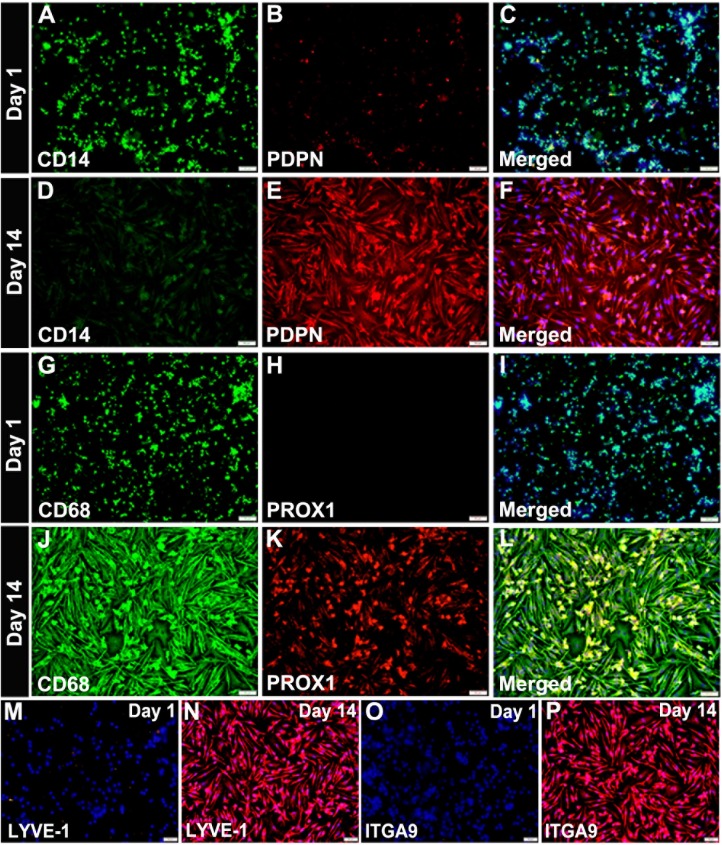
TLR4-reprogrammed monocytes upregulate LEC-specific proteins and downregulate some myeloid markers.CD14+ monocytes seeded on slides were double-stained on Day 1 in culture or on Day 14 (10 days with CSF1 followed by 4 days LPS) for expression of myeloid markers (A, D) CD14, and (G, J) CD68, and lymphatic-specific proteins (B, E) PDPN, and (H, K) PROX1. Double-staining of myeloid and LEC markers (A to L) used FITC- and Cy3-conjugated secondary antibodies, respectively. Single staining with Cy3-conjugated secondary antibodies was performed on cells at day 1 and 14 to detect LYVE-1 (M, N) and ITGA9 (O, P). Merged images of myeloid and lymphatic proteins detected in the same cells are shown in panels C, F, I and L. All images were acquired at 200X magnification.